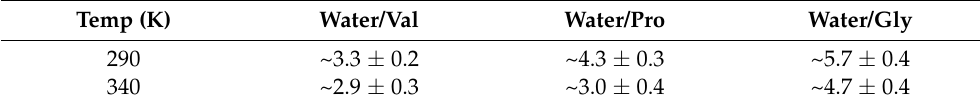
Table 1. Number of water molecules in first hydration shell at both 290 and 340